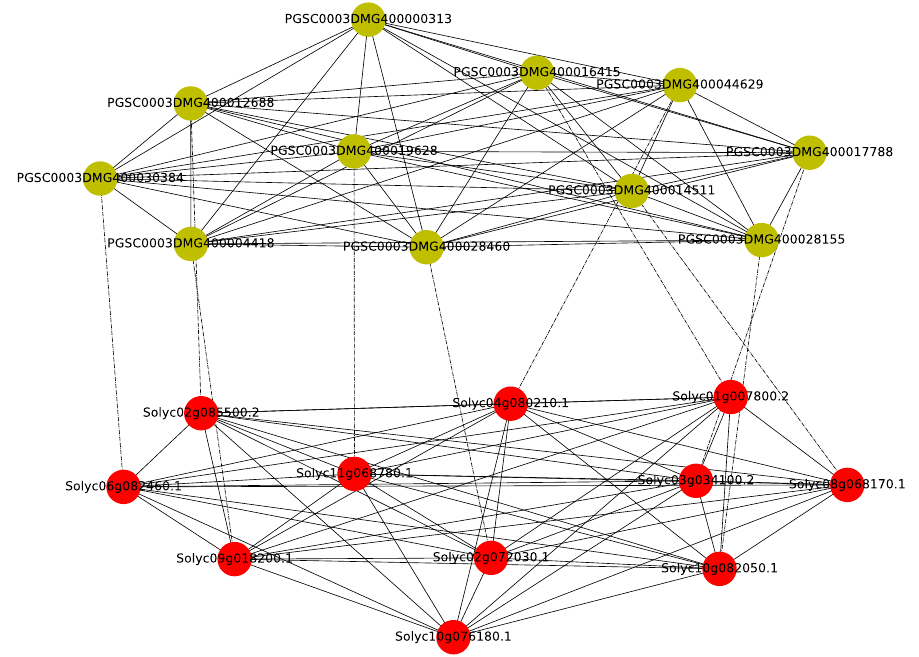
Figure 6. A network of Solyc10g076180.1 homologs in tomato (red) and potato (green) including paralogous (solid) and orthologous relations (dotted). There is no ortholog of OFP20 gene in